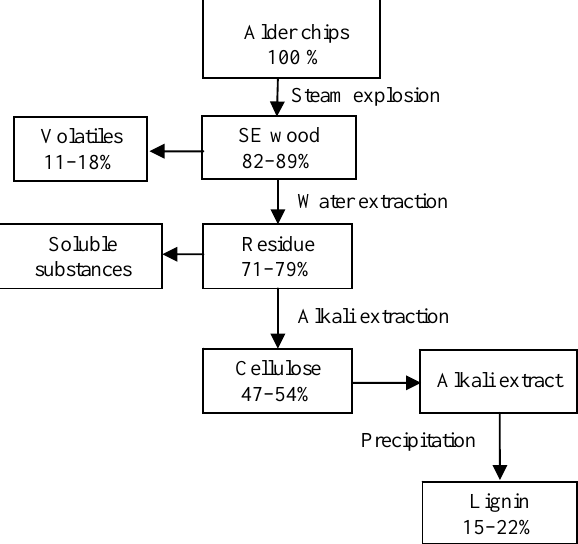
Fig. 2. Separation of the main components of steam-exploded wood